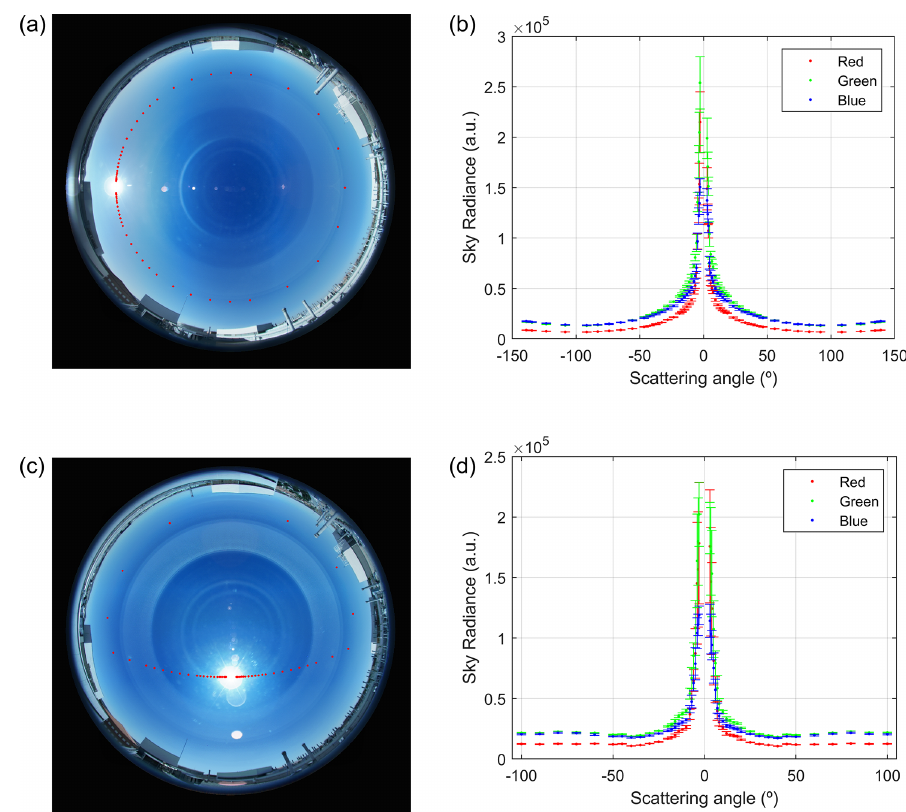
Figure 9. Camera sky radiance at the three channels (b, d) for almucantar (a, b) and hybrid (c, d) scans on 17 August at 07:25UTC and 12:25UTC, respectively. Panels (a) and (c) show in red the almucantar and hybrid sky points on a tone map of the demosaiced HDR